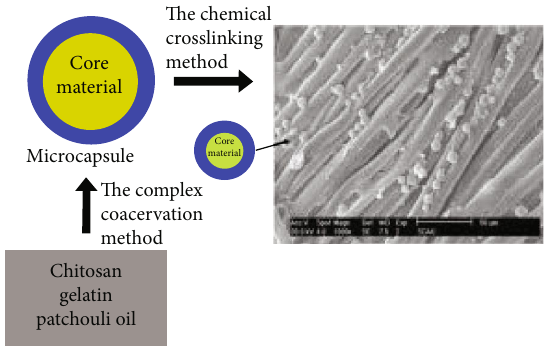
Figure 31: Schematic representation of the chitosan-gelatin microcapsules and crosslinking method (Figure 33), encapsulation e ffi ciency and vitamin C release kinetics, showed that through the concentration of genipin and interaction in the gelatin/NaCAS system, the properties of microcapsules were in fl uenced.